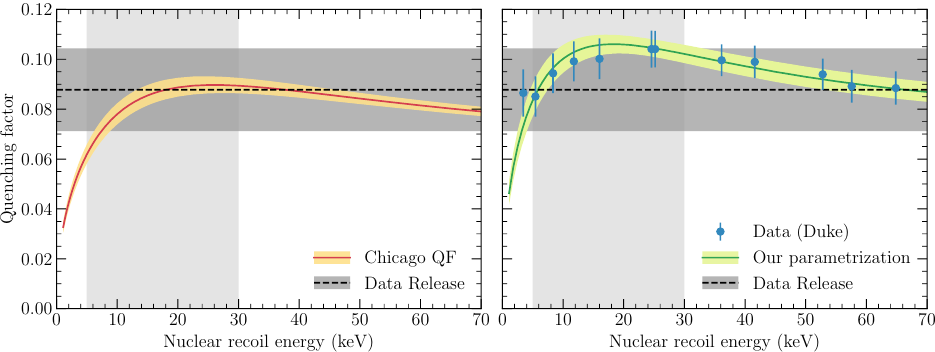
Figure 1 . Quenching Factor parametrizations used in our analysis of the COHERENT data. The left panel shows the curve provided in ref. [58] (solid curve), while the right panel shows the corresponding result obtained for our (cid:12)t to the calibration data of the Duke (TUNL) group [35], provided as part of the data release [36]. In both panels, the constant QF used in ref. [35] is also shown for comparison. The three parametrizations are shown with a shaded band to indicate the values allowed at the 1 (cid:27) CL in each case. For illustration, the vertical shaded area indicates approximately the range of nuclear recoil energies that enters the signal region used in the (cid:12)t (the exact range varies with the nuisance parameters, and the exact QF parametrization